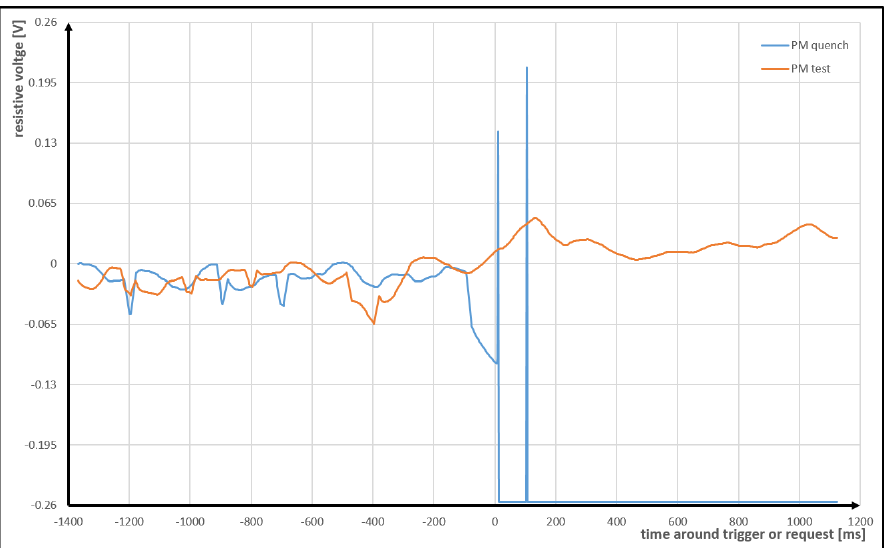
Figure 2. The presentation of a contents of U RES field of two PM data files for one of the superconducting magnets (with electrical current 600A). The voltage range of the ADC is from − 256mV to 256mV. Time 0ms refers to trigger (request) time stored in the field QUENCHTIME in the PM data